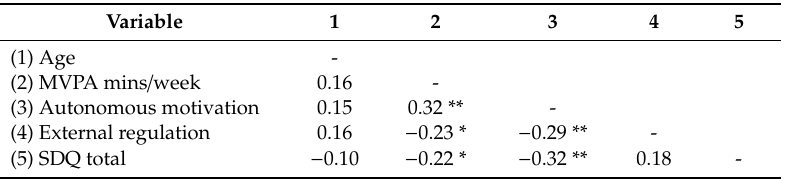
Table 2. Bivariate Pearson correlations among